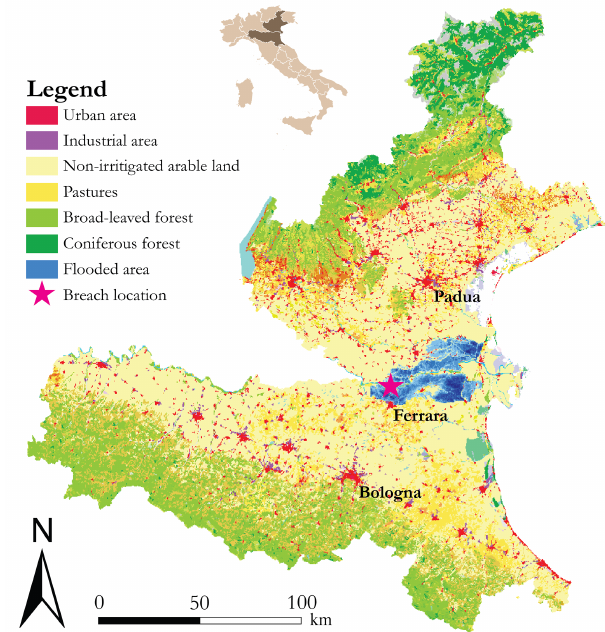
Table 3. Asset losses of the affected regions